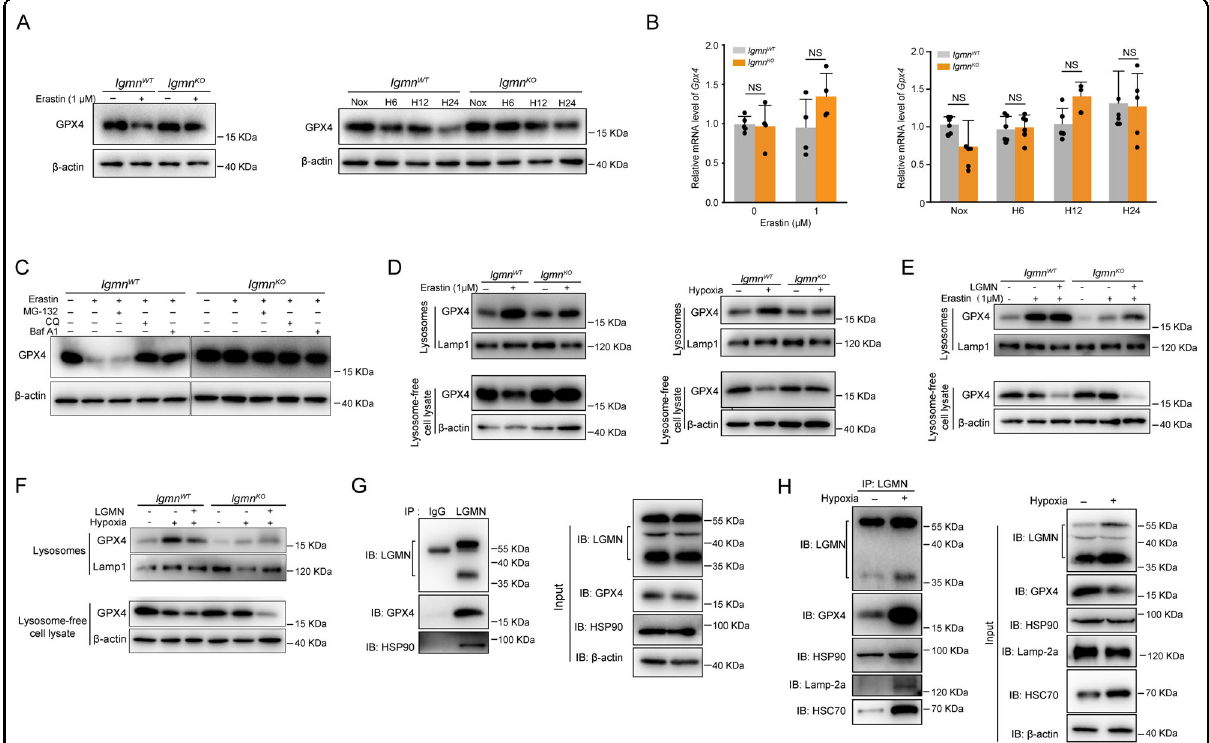
Fig. 5 Legumain promotes chaperone-mediated autophagy of GPX4. Primary lgmn WT and lgmn KO mRTECs were treated with 1 μ M erastin for 24 hours or incubated under normoxic or hypoxic conditions for 6, 12, and 24 hours. A Western blot assay of GPX4. B Quanti fi cation of GPX4 mRNA levels by qPCR. Primary lgmn WT and lgmn KO mRTECs were pretreated with MG132, CQ, and Baf A1 for 2 hours before treatment with 1 μ M erastin for 24 h. C Western blot using an antibody against GPX4. D mRTECs were treated with 1 μ M erastin for 24 h or incubated under hypoxic conditions for 24 h. Lysosomes and lysosome-free cell lysates were collected and the protein level of GPX4 was measured by western blotting. Lamp1 and β -actin were used as loading controls of lysosomal and non-lysosomal proteins, respectively. E , F Primary mRTECs from lgmn WT and lgmn KO mice were infected with control or legumain-overexpressing lentiviral constructs for 48 h and then treated with 1 μ M erastin or incubated under hypoxic conditions. Western blotting was performed using an antibody against GPX4. G In cultured HK-2 cells, a co-IP assay was performed using an antibody against legumain or control IgG and western blotting for legumain, GPX4, Lamp-2a, HSC70, and HSP90 was performed. H HK-2 cells were incubated under normoxic or hypoxic conditions for 24 h. Co-IP assays were performed using an antibody against legumain or control IgG and then western blotting for legumain, GPX4, Lamp-2a, HSC70, and HSP90 was